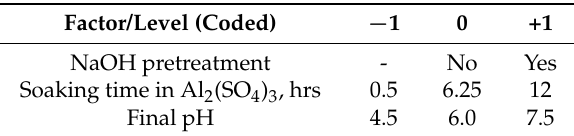
Table 2. Factors and levels used for the chemical